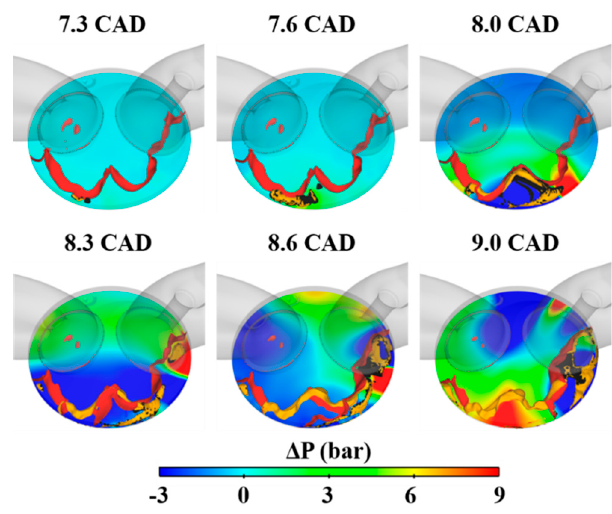
Figure 19. Evolution of 3D in-cylinder combustion process at u / u 0 = 1.5.